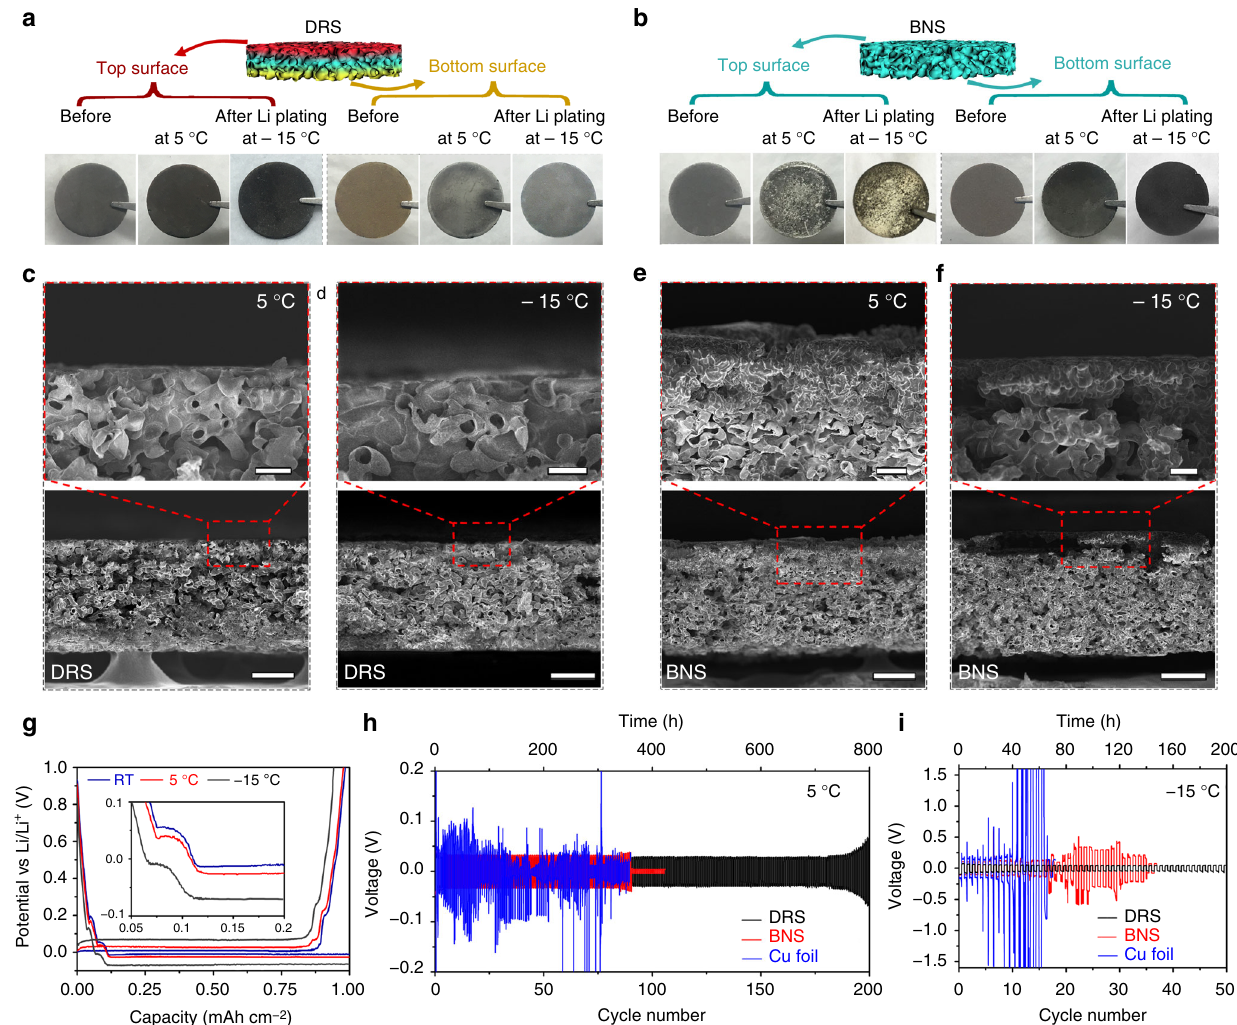
Fig. 5 Low-temperature characterizations and electrochemical properties. Optical images of the top and bottom surfaces of a DRS and b BNS before and after Li plating at 5 °C and − 15 °C. c – f Cross-section SEM images of the top regions at high magni fi cation of ( c , d ) DRS and ( e , f ) BNS surfaces at 5 °C and − 15 °C. g Voltage pro fi les of Li plating/stripping on the DRS at 0.25 mA cm − 2 . Cycling properties of symmetric cells consisting of DRS, BNS, or Cu foil at 0.5 mA cm − 2 with a limited capacity of 1 mAh cm − 2 at h 5 °C and i − 15 °C. Scale bars: top images of ( c − f ), 5 μ m; bottom images of ( c − f ), 25 μ